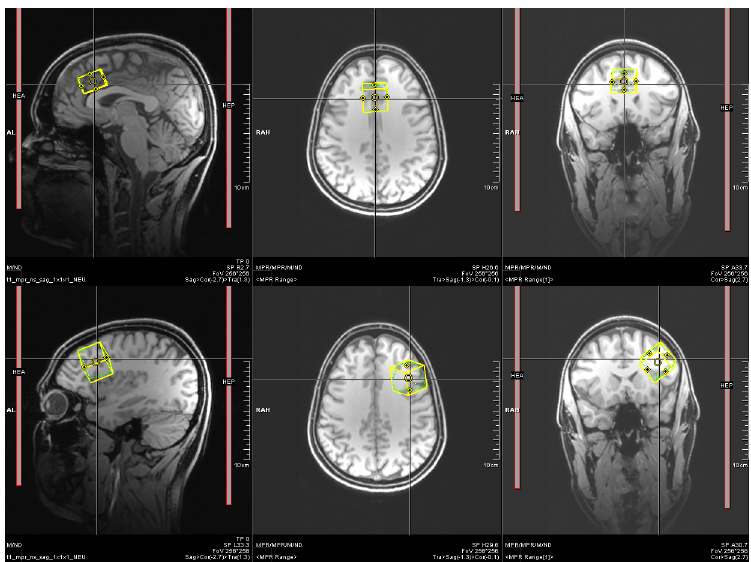
Fig 1. Voxel localization in the ACC (top), and the right DLPFC (bottom) for one